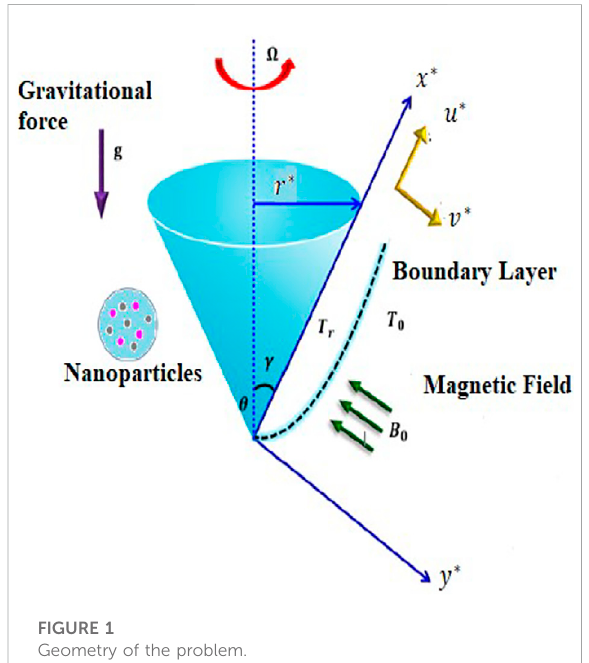
FIGURE 1 Geometry of the problem.